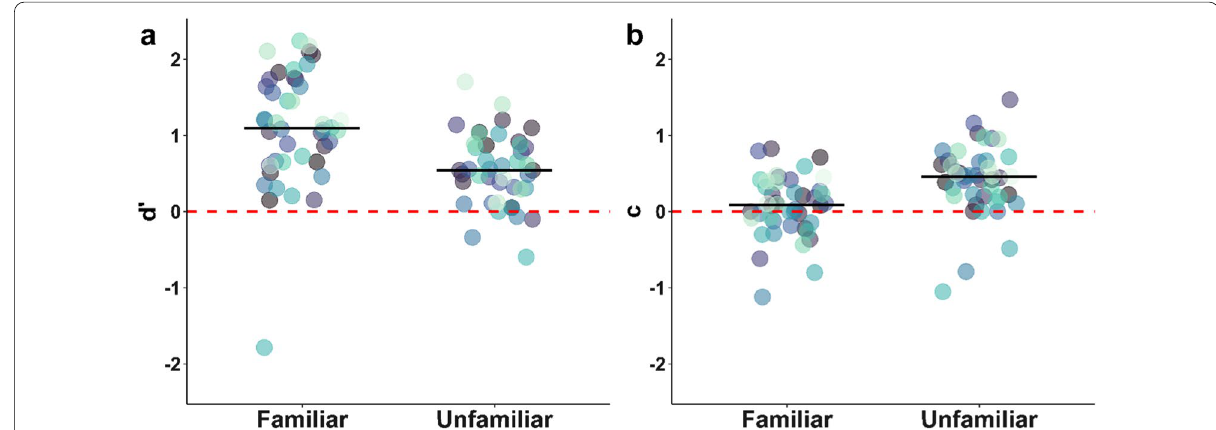
Fig. 2 Sensitivity ( d ′ ) and response bias ( c ) for identity recognition, depending on the familiarity of faces. Note. Black horizontal lines indicate median values. Same colors indicate data points from the same participant. Each data point shows the sensitivity ( d ′ ; panel a ) or response bias ( c ; panel b ) of a single participant indicating whether they saw a given face in the study phase, separately for familiar and unfamiliar faces. a Advantage for remembering familiar faces. Higher values of d ′ indicate better performance. A value of zero indicates ‘guessing.’ b Stronger conservative bias for